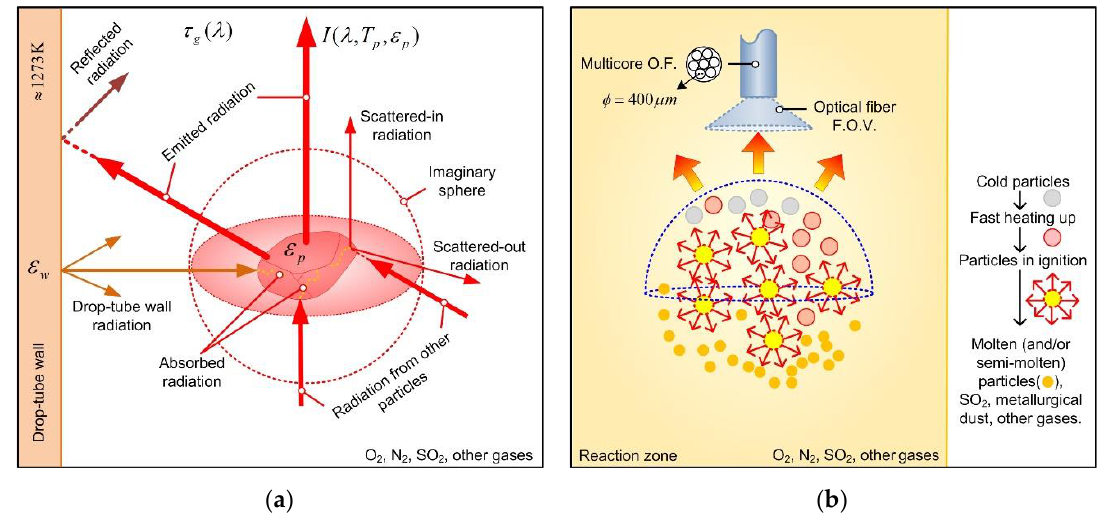
Figure 2. Radiometric measurement scheme and associated radiative processes: ( a ) Single heated particle radiative emission with its surroundings; ( b ) sensing scheme depicting the different particle states during their passing through the reaction zone.